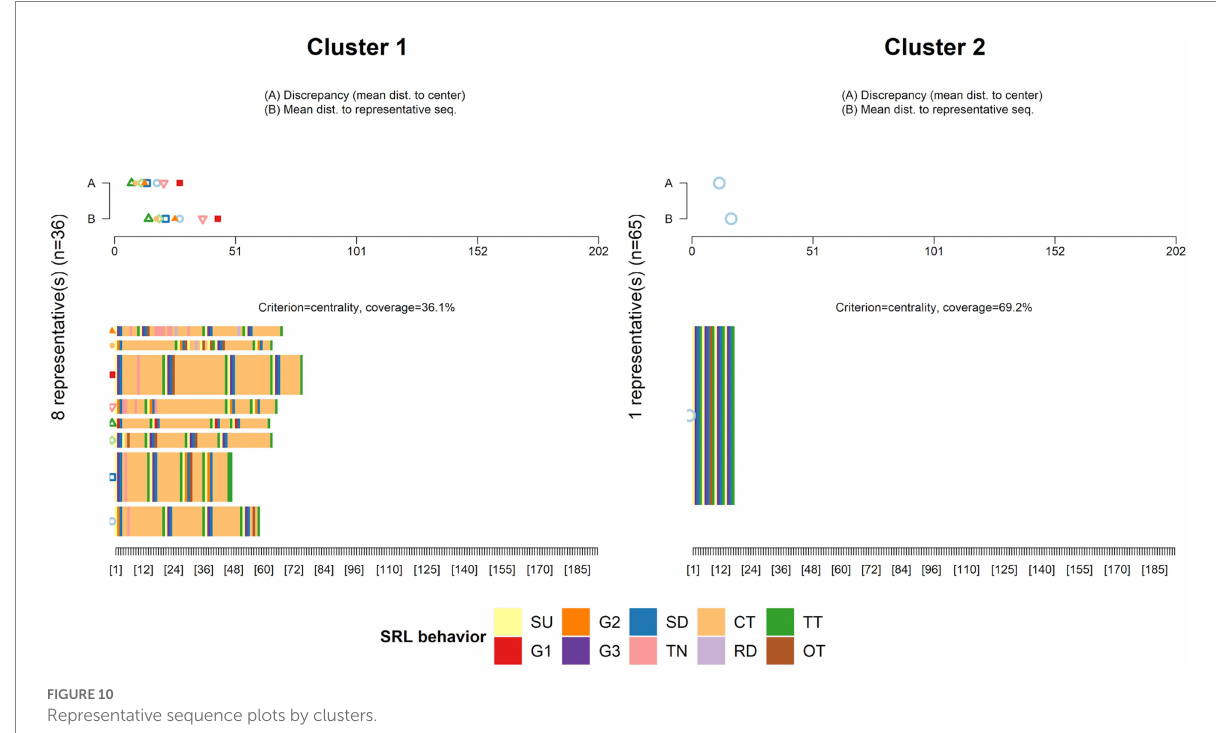
FIGURE 10 Representative sequence plots by clusters.